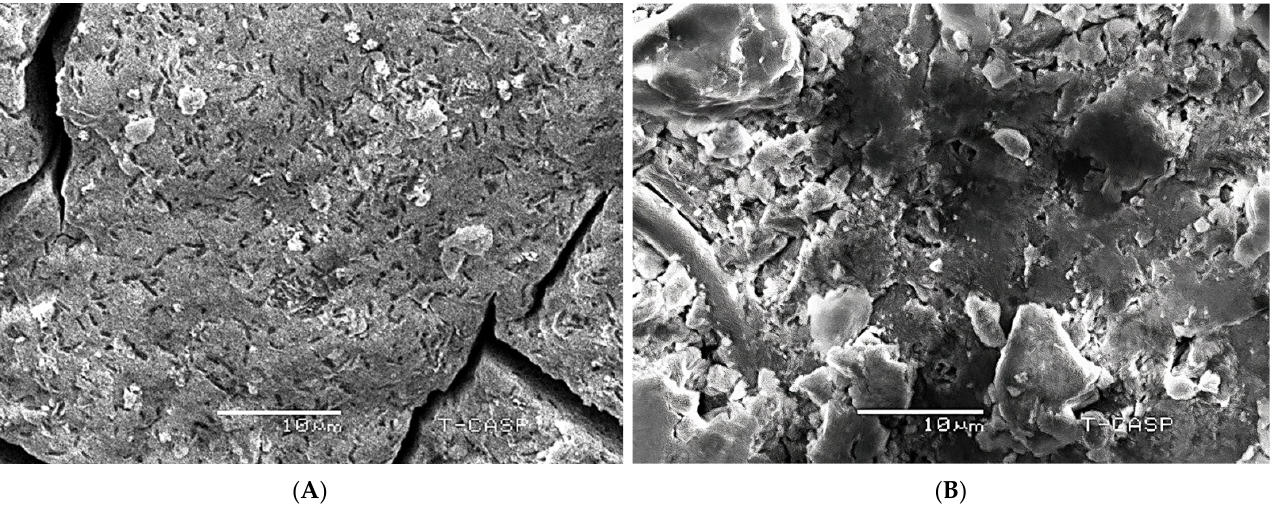
Figure 5. ( A ) SEM micrograph of silver nanoparticles synthesized using the 25 mM solution of AgNO 3 and leaf extract of Acer oblongifolium ; ( B ) SEM micrograph of silver nanoparticles synthesized using the 1 M solution of AgNO 3 and leaf extract of Acer oblongifolium.